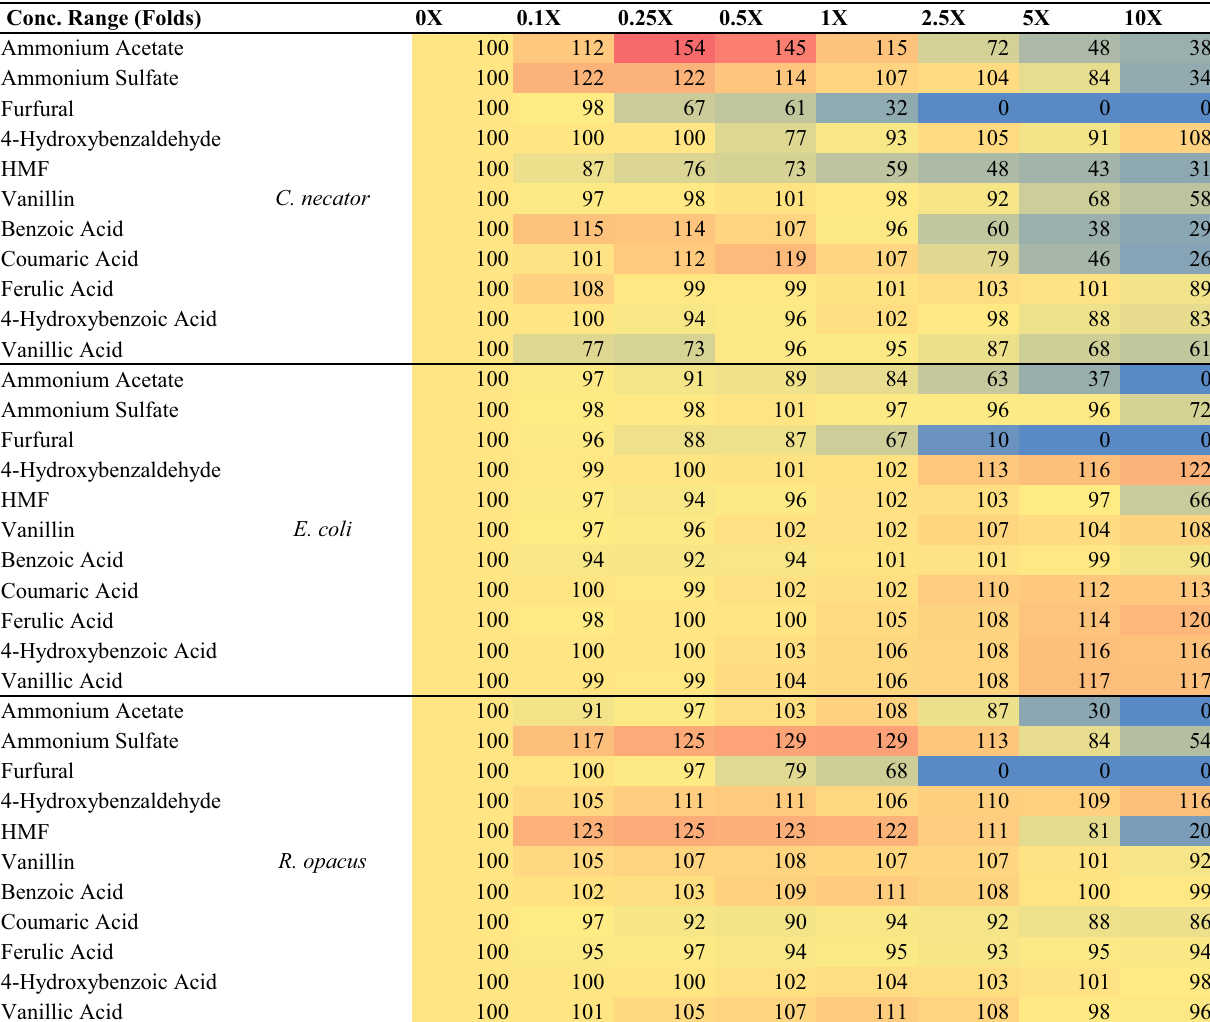
TaBle 3 | The responses, given as the percent growth rate compared with the no inhibitor control, of three bacterial strains strains of C. necator H16G + 7, E. coli , and R. opacus PD630 to 11 potential pretreatment inhibitors supplemented in the medium at the concentration ranges from 0- to 10-folds of that detected in the saccharified